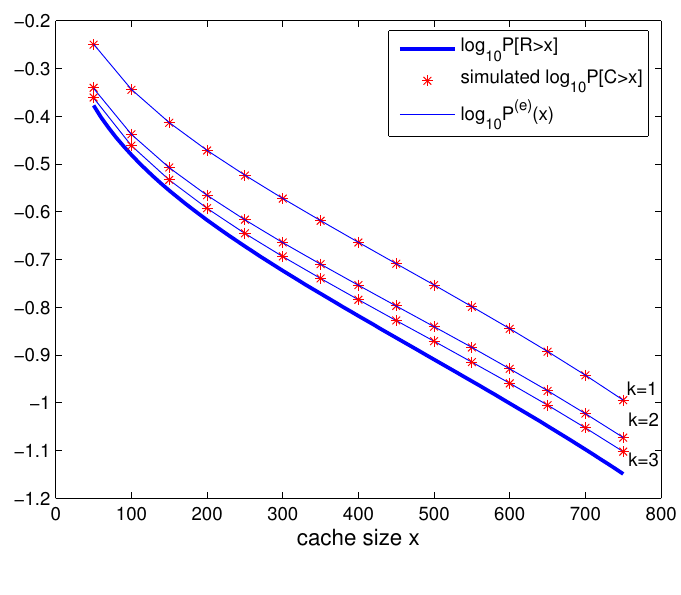
Fig. 2: Illustration for Experiment 2.